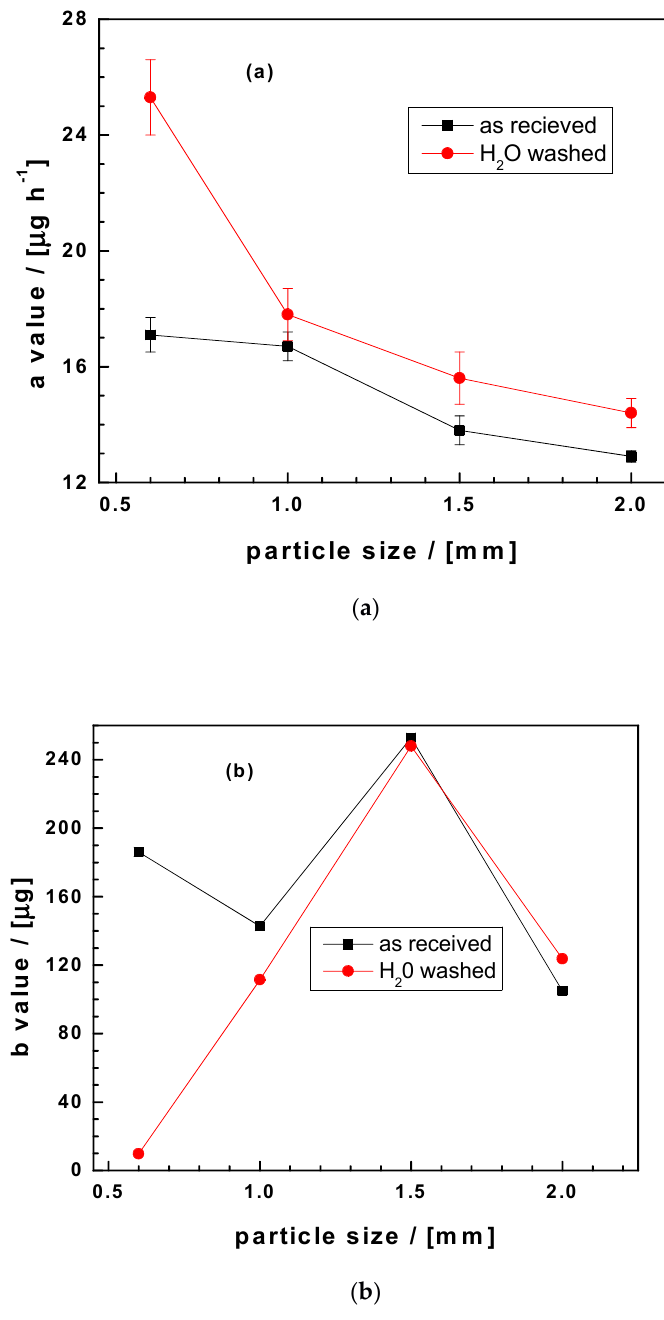
Figure 4. Changes of the regression parameters ( a , b ) for the EDTA test for four Fe 0 samples as influenced by pre-washing in tap water for 14 h. The selected samples (ZVI5 through ZVI8) are represented by their mean particle size (Table 1). Error bars denote the standard error for triplicate experimental results. Experimental conditions: V = 50 mL, m ZVI = 0.1 g. The lines are not fitting functions, they simply connect points to facilitate visualization.